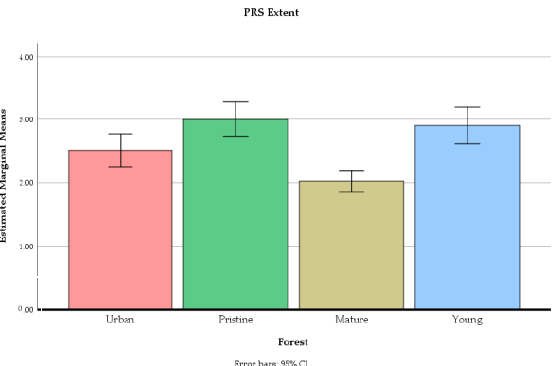
Figure 8. The mean values of PRS extent (not reversed) in four different forests at the end of the experiment. Error bars represent 95% confidence intervals.